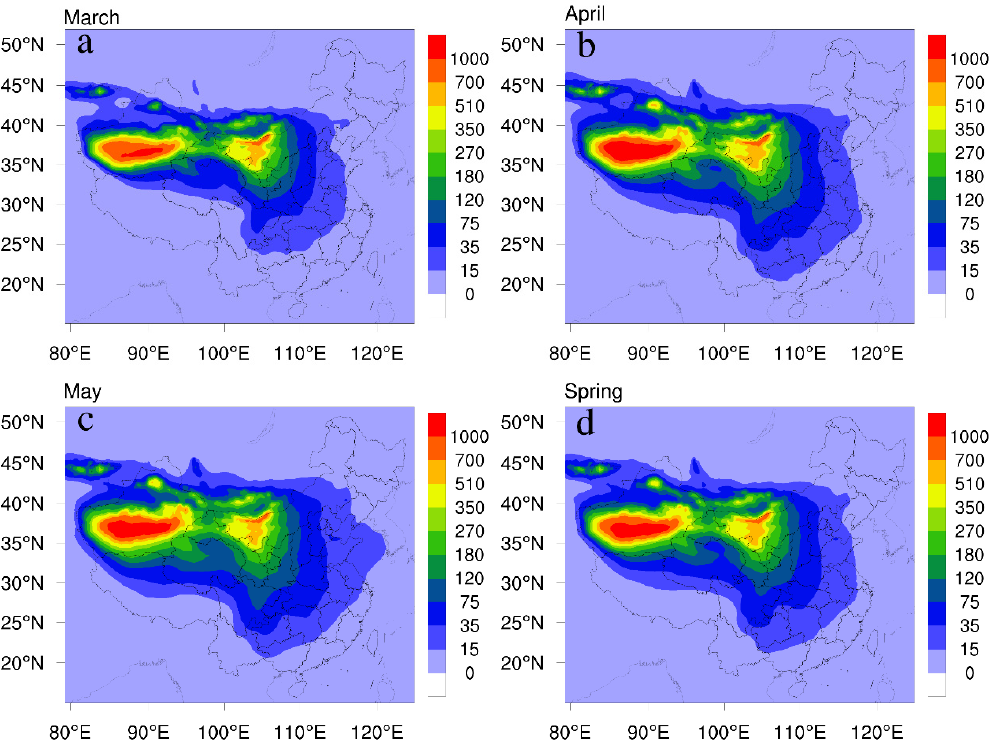
Figure 5. Spatial distributions of annual mean dust concentrations ( µ g kg − 1 -dry air) of China in March ( a ), April ( b ), May ( c ), and spring ( d ) during 2000 − 2020. In March, the spatial pattern of high dust concentration (>500 µ g kg − 1 ) was similar to that in April and May, mainly concentrated in southern Xinjiang and western Inner Mongolia, and the maximum dust concentration reached 1270 µ g kg − 1 . The coverage area of high dust concentration in April was larger than that in March, and the maximum dust concentration was 1625 µ g kg − 1 . In addition, the coverage of the dust aerosol also expanded to the southeast and spread to the west of Zhejiang and the north of